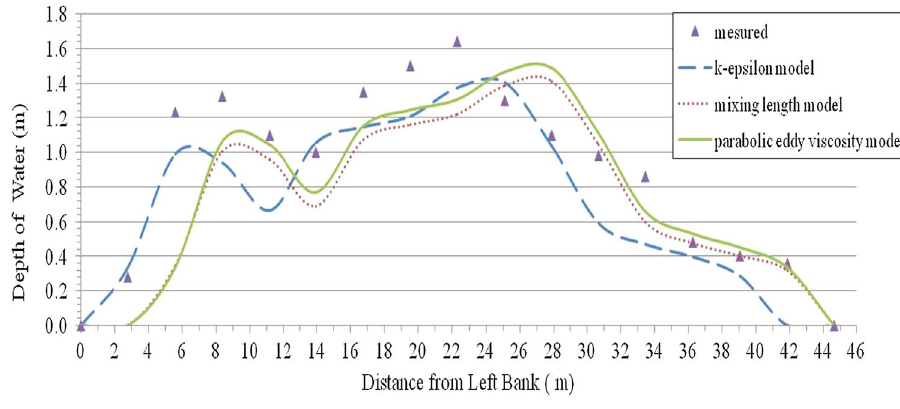
Fig. 6 Water depth profiles at cross section of Shahmokhtar station for different turbulent models